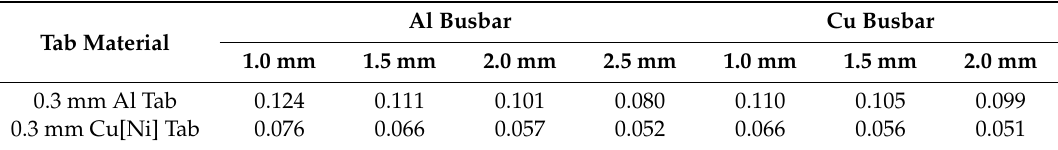
Table 4. The maximum values of electrical resistance obtained from all tab and busbar combinations.